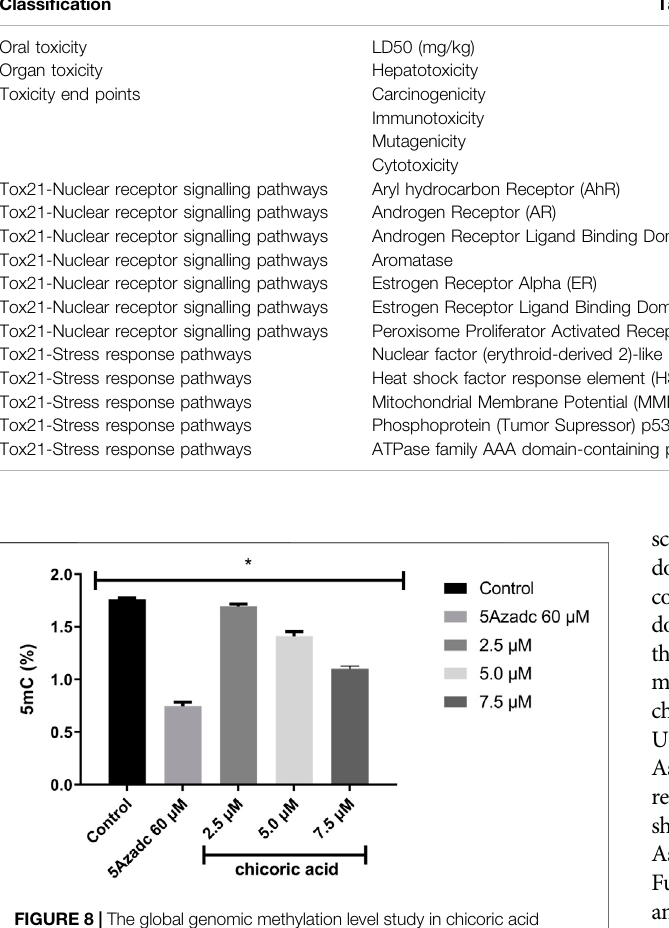
TABLE 2 | Toxicity analysis of chicoric acid with different parameters such as, organ toxicity, toxicity endpoints, and signaling and response pathways. Classi fi cation